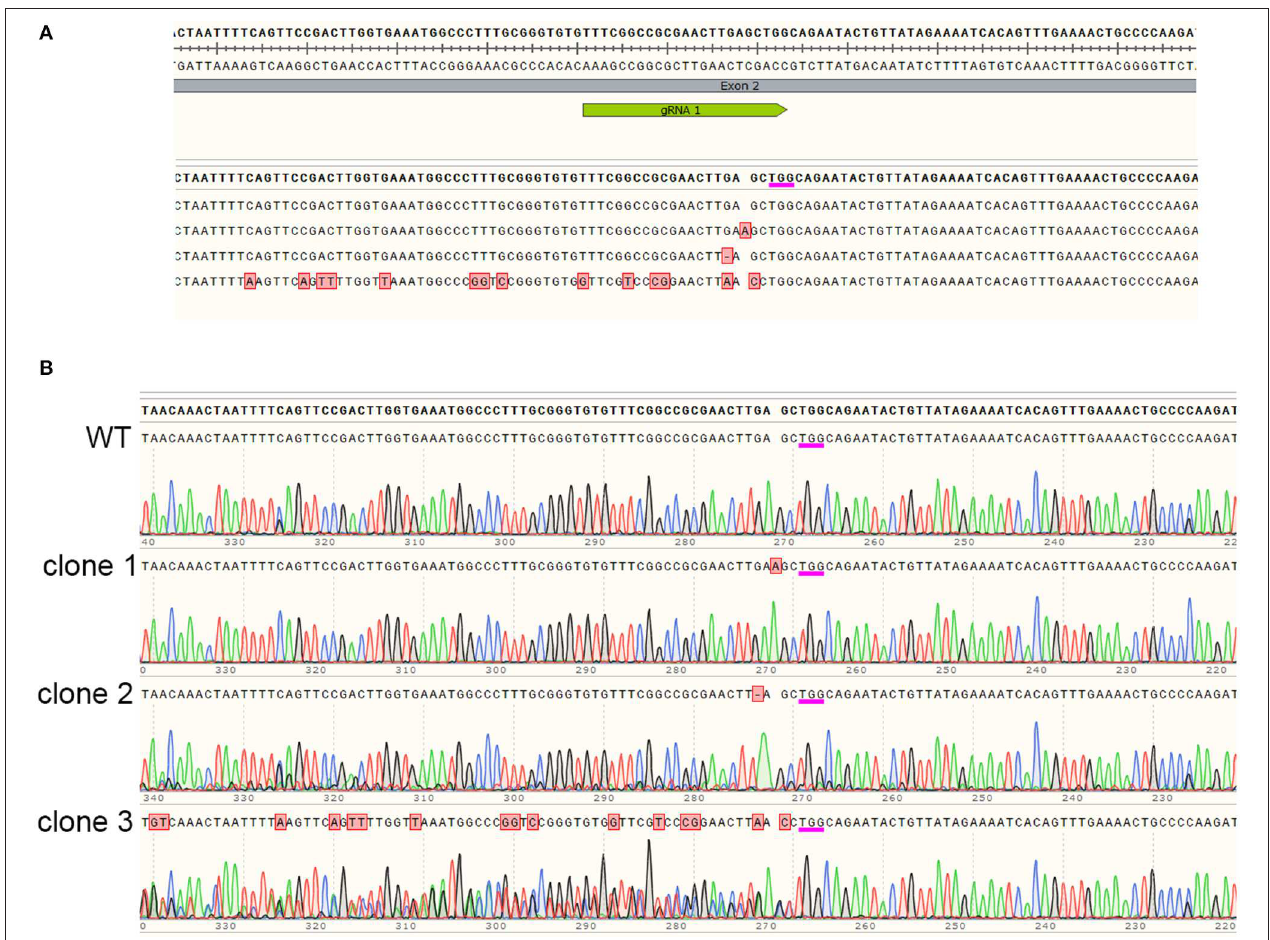
FIGURE 4 | Sequence analysis of edited lines. Mutations in JrPDS of selected lines displaying stunted or albino phenotypes were investigated by DNA sequencing. (A) Alignment of sequencing reads obtained from selected edited lines. Sequence on top shows site of gRNA annealing and PAM site (underlined in magenta) with reads showing detected mutations in red, or the lack of mutations in a wild type clone. (B) Sequence chromatograms of the reads shown in the top panel, revealing the original sequence, a mutated line with a adenosine insertion, a mutated line with a guanosine deletion, and the bottom read which seemed to contain multiple mutations, but revealed edition of only one of the alleles, generating an heterozygotic region during the sequencing